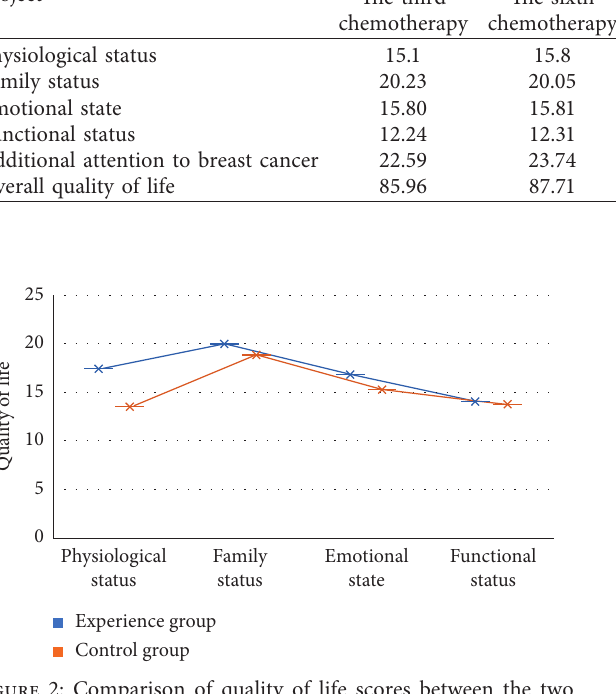
Table 2: Quality of life scores of the intervention group and control group in the third, sixth, and ninth chemotherapies. Project